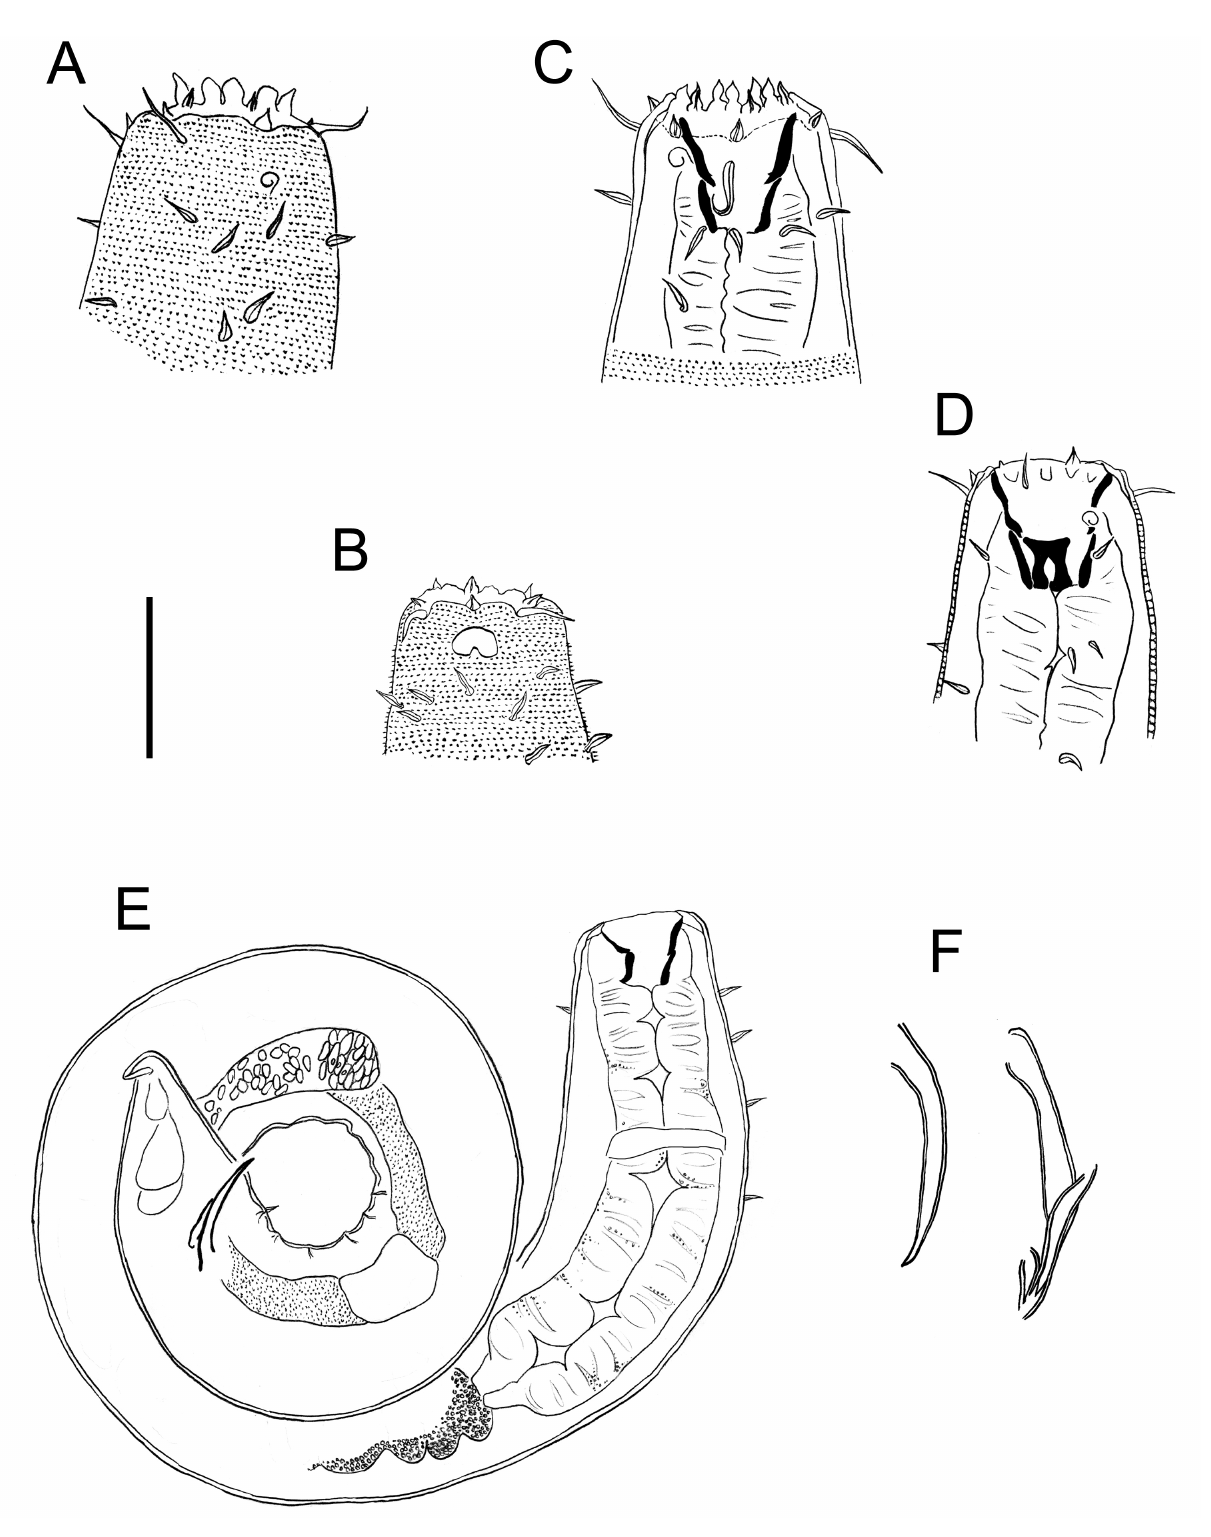
Fig. 11. Gammanema agglutinans sp. nov. A . Surface view of female head. B . Surface view of male head. C . Female head, showing buccal cavity. D . Female head, showing buccal cavity. E . Entire male. F . Spicule and gubernaculum. Scale bar: A-D = 30 µ m; E = 40 µ m; F = 18